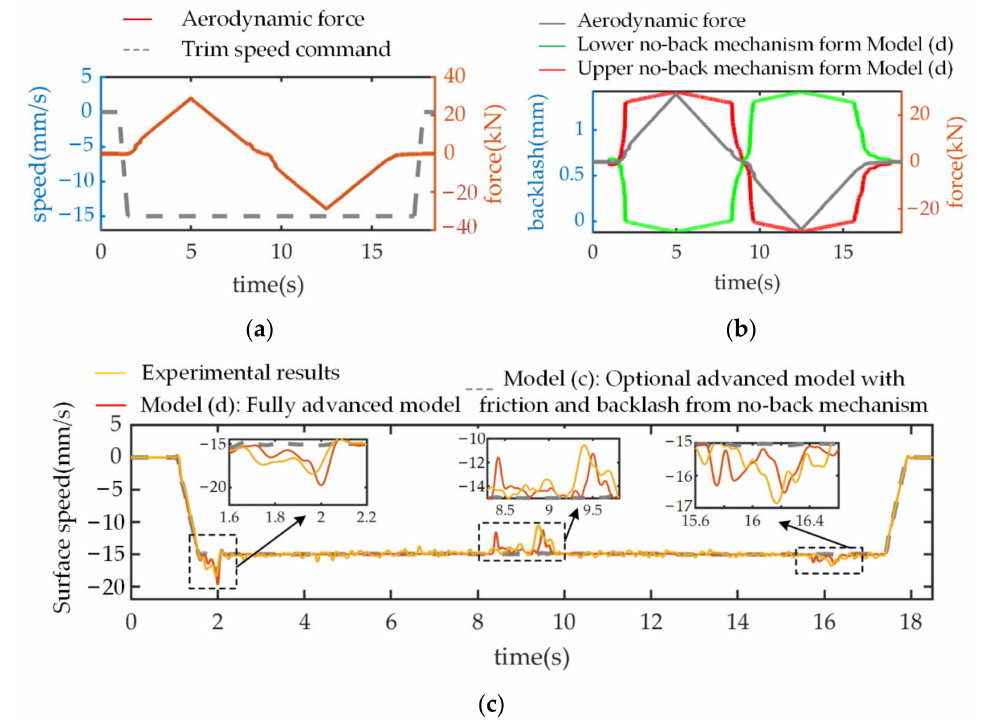
Figure 10. Simulation responses and experimental results under unipolar speed command and triangular load. ( a ) Speed command and load force input; ( b ) Backlash variations versus load force; ( c ) Surface speed responses from different level models and experimental